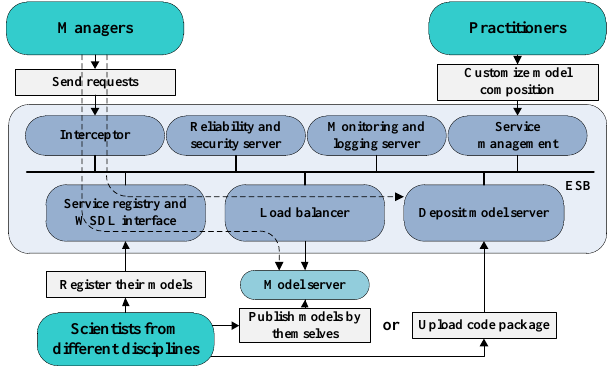
Fig. 5. Open library of optimization and mathematical program- ming